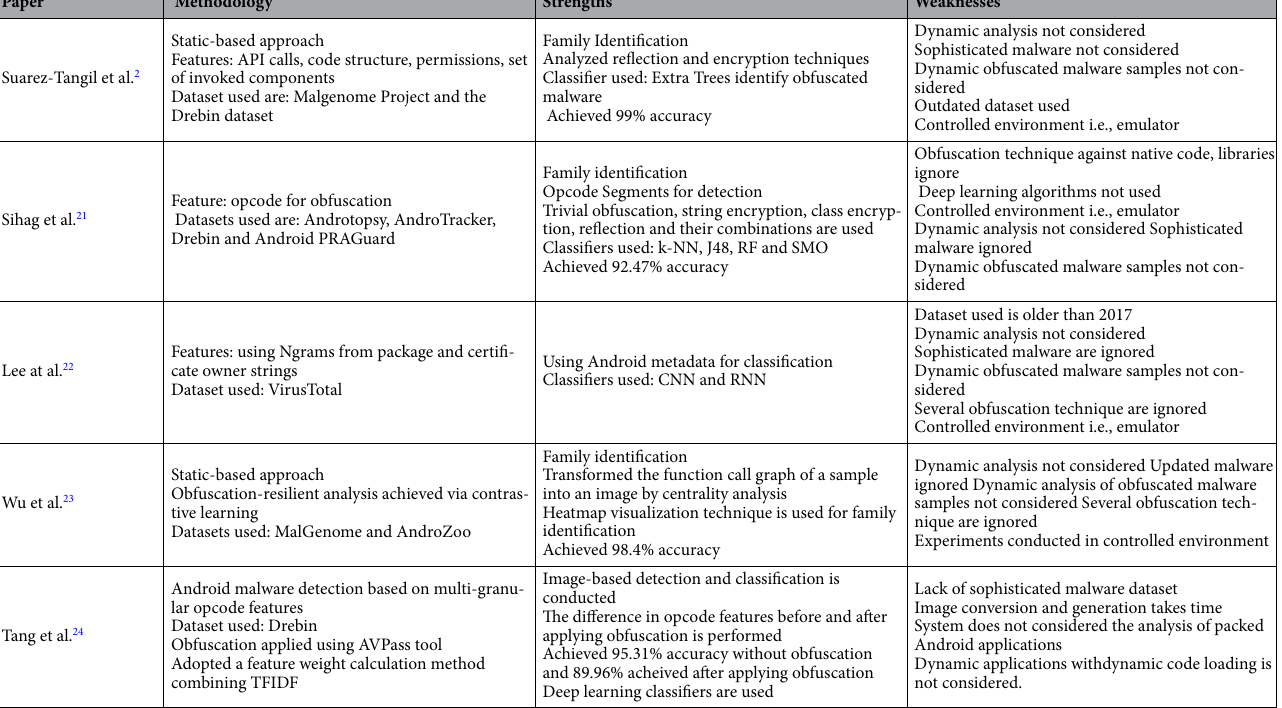
Table 1. Summary of the proposed approach with the state-of-the-art existing